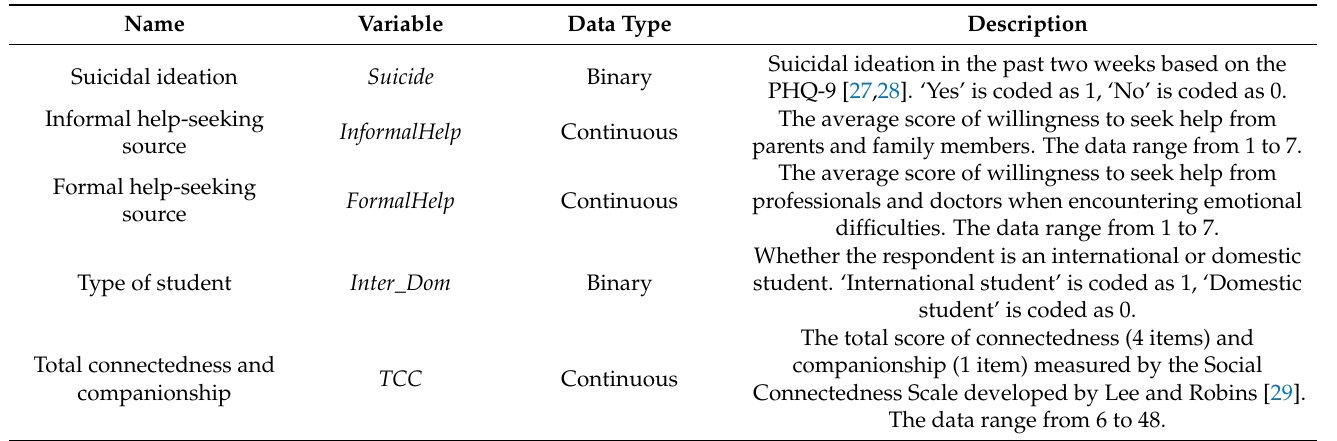
Table 1. Variable